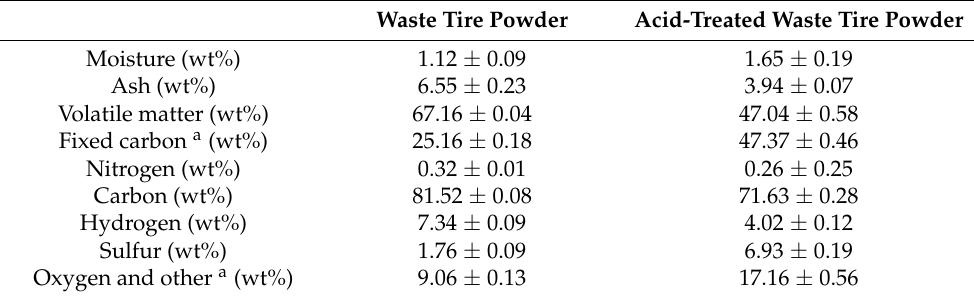
Table 1. Proximal and elemental analyses of the waste tire powder and acid-treated waste tire powder. Waste Tire